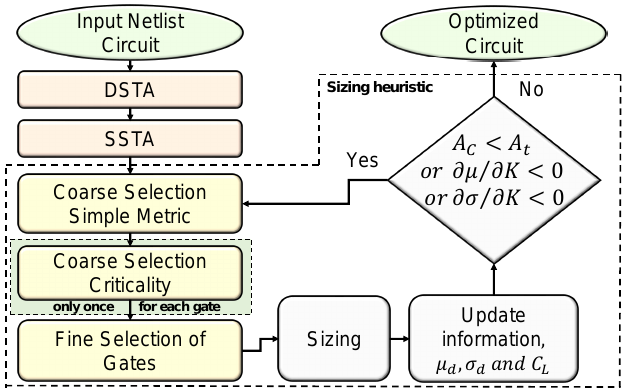
Figure 1. Flow diagram of the proposed circuit performance optimization